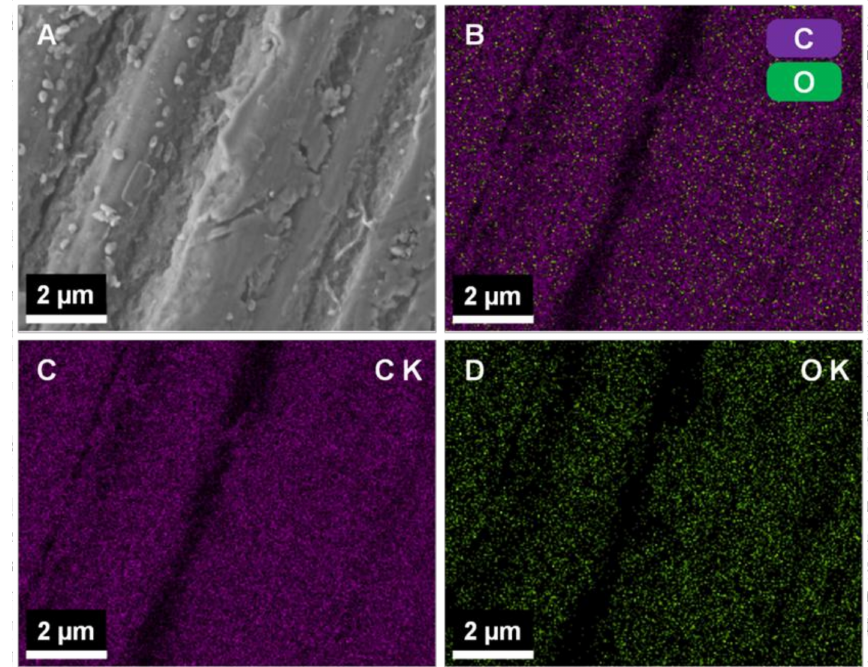
Figure 2. ( A ) SEM micrograph of the acid treated graphite felts, OGFs-24, ( B ) Elemental mapping showing the presence of C and O on the sample surface. ( C , D ) Elemental maps of carbon and oxygen elements on the OGFs-24 surface.